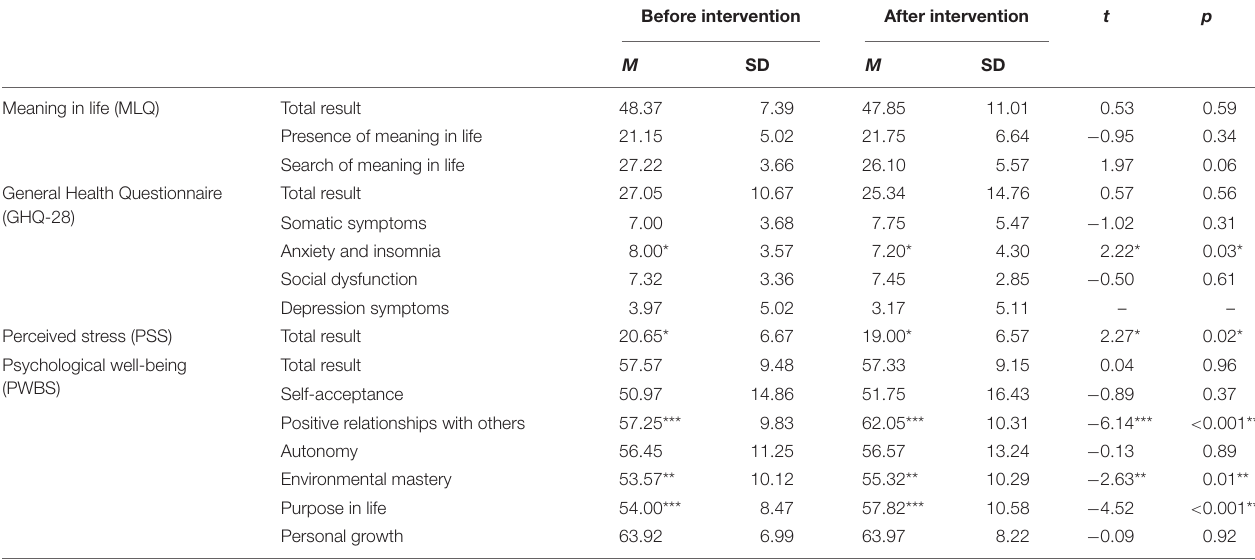
TABLE 2 | Comparison of the level of meaning in life, general health, perceived stress and psychological well-being before and after intervention in experimental group (with intervention) ( n =